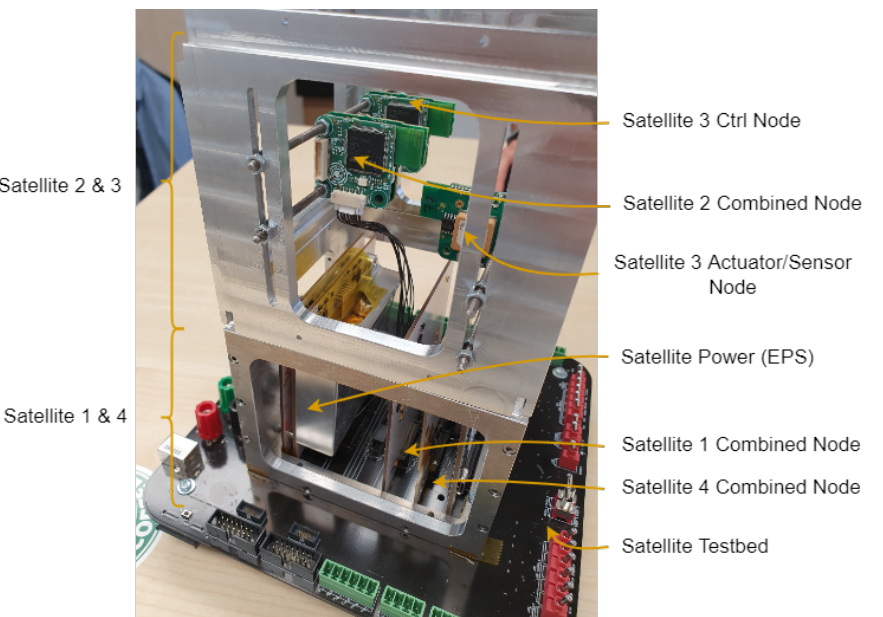
Figure 13. Hardware testbed used for the experiments: Two cube units each containing one or more connected hardware nodes which are associated with one of four satellites. The units are stacked on an electrical test interface board used for external